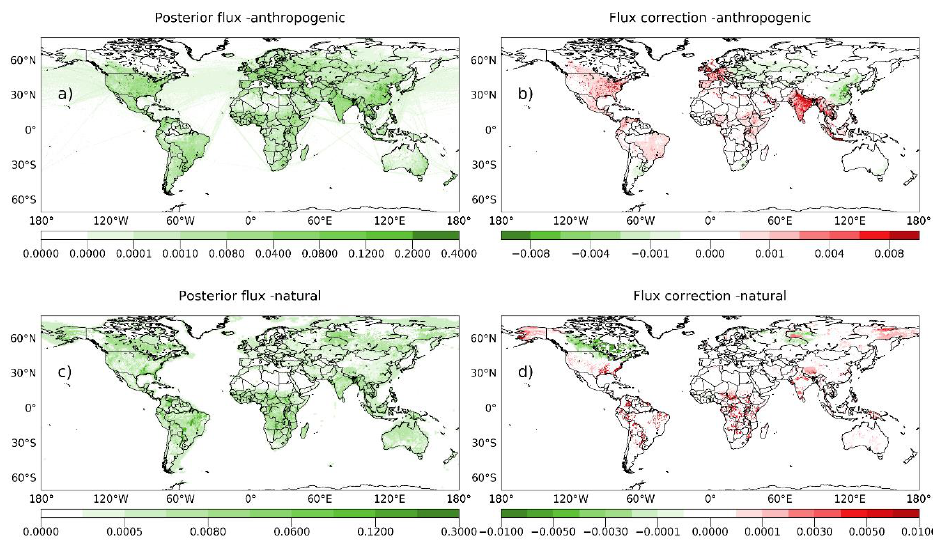
Figure 3. Posterior fluxes ( a and c ) and the corresponding flux corrections ( b and d ) by inverse model, averaged for 2011–2017, for natural (bottom panel) and anthropogenic (upper panel) categories. The units are in g CH 4 m −2 d −1 . Note that the administrative boundaries depicted in the figure may not reflect the actual political boundaries.